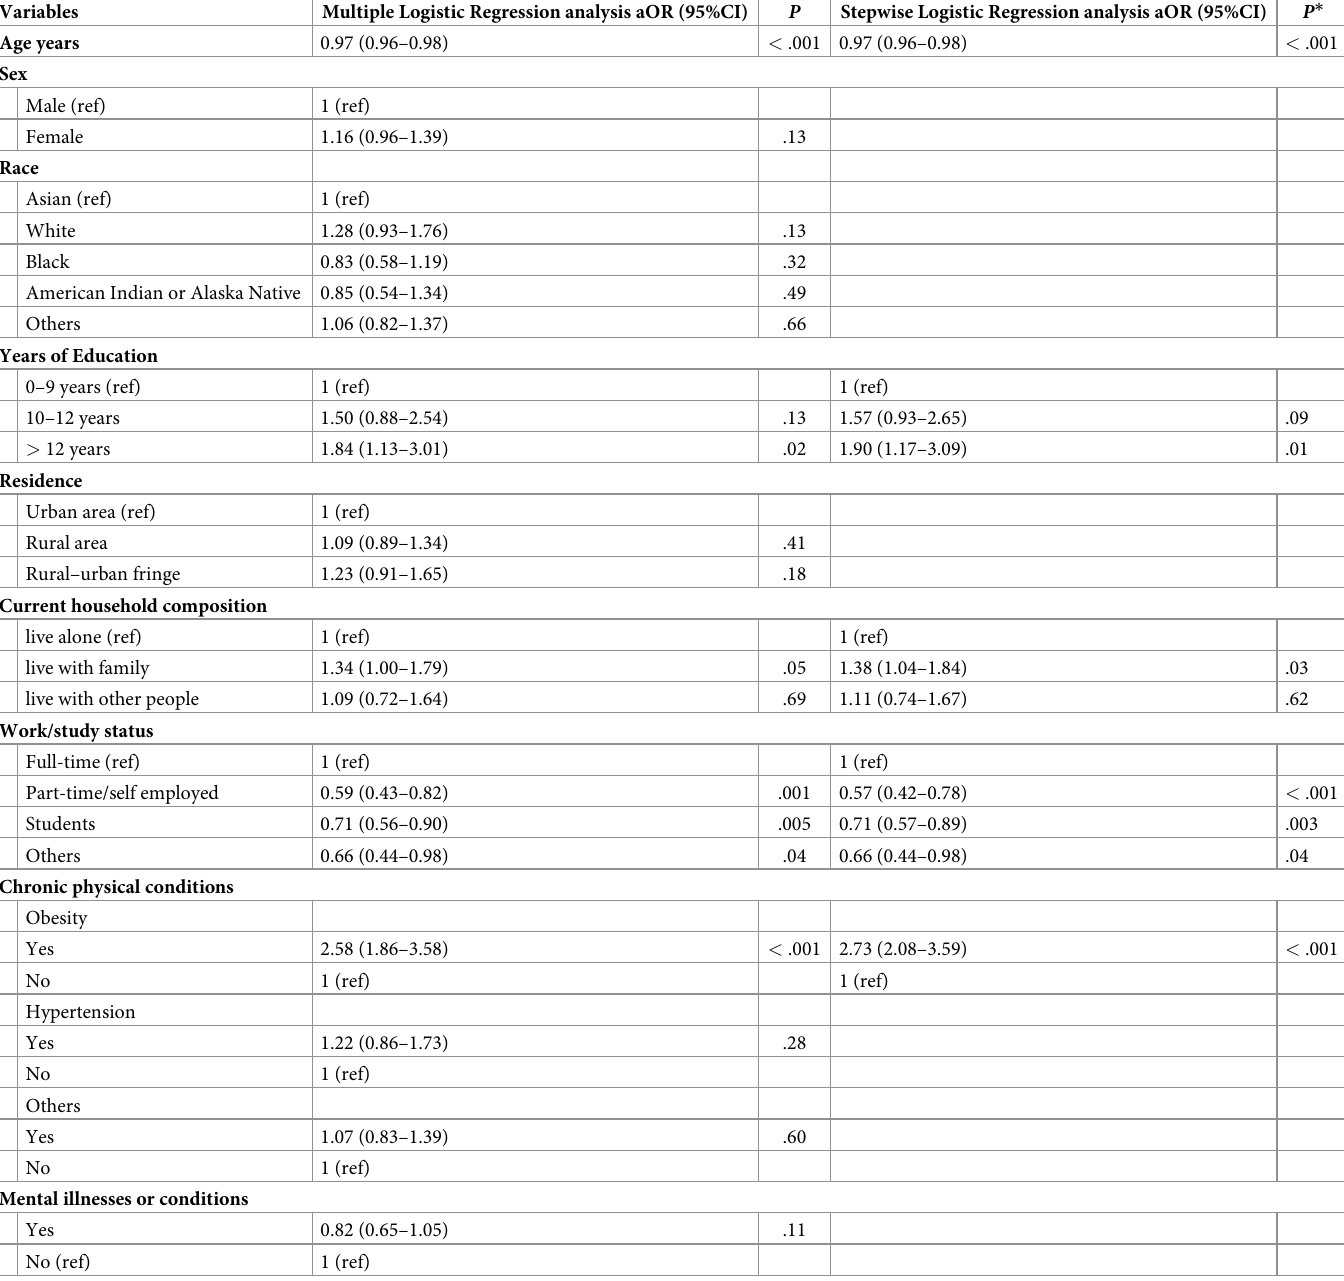
Table 2. Socio-demographic factors associated with increased weight in the past six